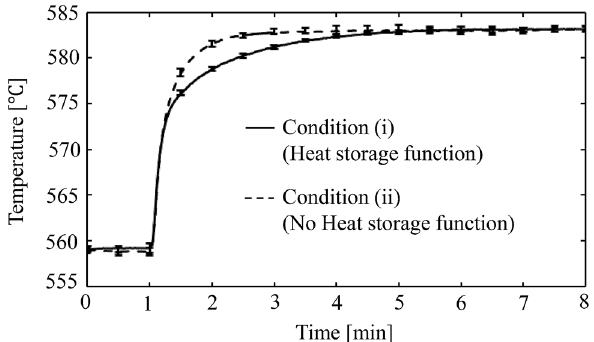
Figure 10. The temperature change of the Ni/MEPCM layer during CO 2 methanation. Feed gas was introduced at 1 min after the starts of measurement. In the condition (i), the MEPCM has heat storage capacity. In the condition (ii), the MEPCM does not have it. Reaction condition: F in , CO 2 = 15 ml min −1 , F in , H 2 = 60 ml min −1 , F in , Ar = 50 ml min −1 , Reaction temperature: 560 °C. Each curve represents the average temperature of five measurements, and error bars indicate SD of temperature at each